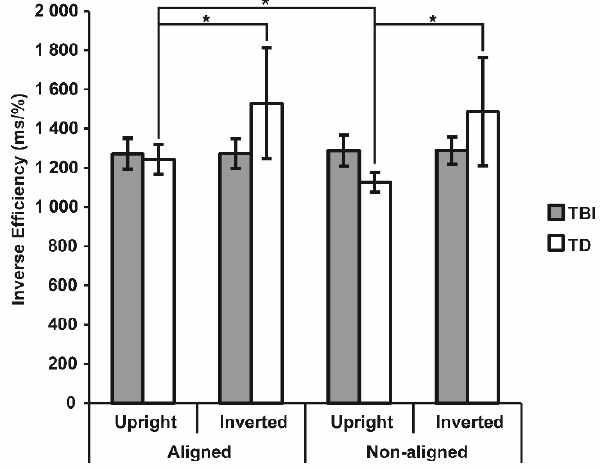
Figure 2. Inverse effect (IE) for each condition of the Visual Body Recognition task for the two groups. Bars indicate Standard Error of the Mean of measurements of 16 same-response trials in six blocks (N = 96) for 33 children with traumatic brain injury (TBI) and 33 TD (typically developing) children. Dotted black lines show within-group comparisons, with asterisks indicating significant p < 0.05.